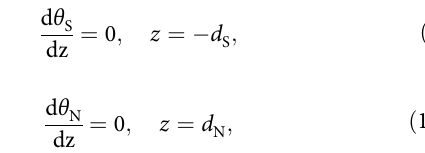
ffiffiffiffiffiffiffiffiffiffiffiffiffiffiffiffiffiffiffiffiffiffiffiffiffi p (cid:1) hD = 2 π k T , D N is the diffusion N B c